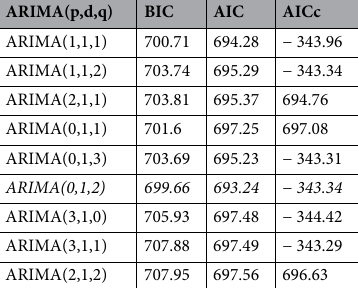
Table 2. Summary of estimation for ARIMA models. Significant values are in